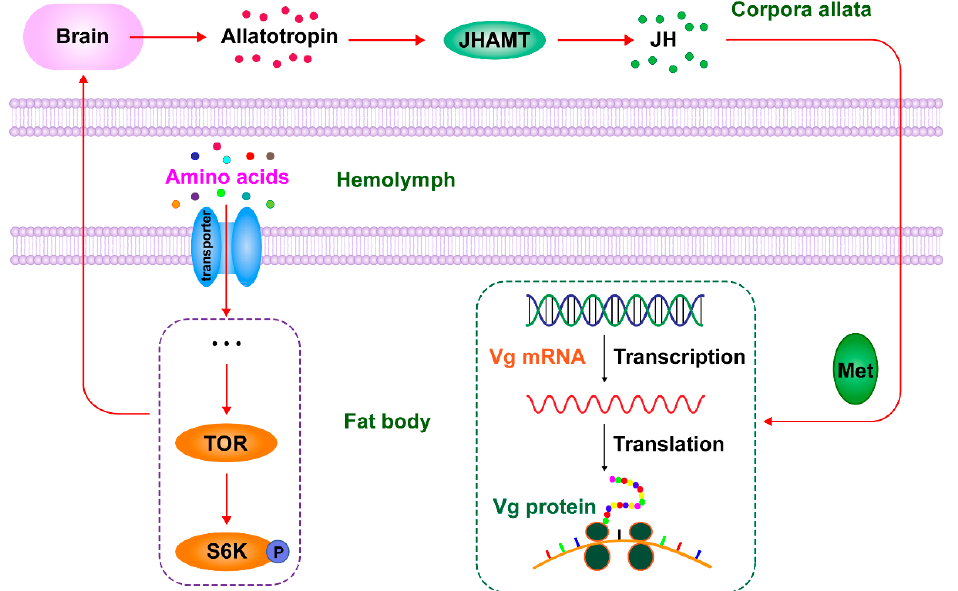
Figure 7. A proposed model for the TOR pathway and JH in regulating Vg synthesis responding